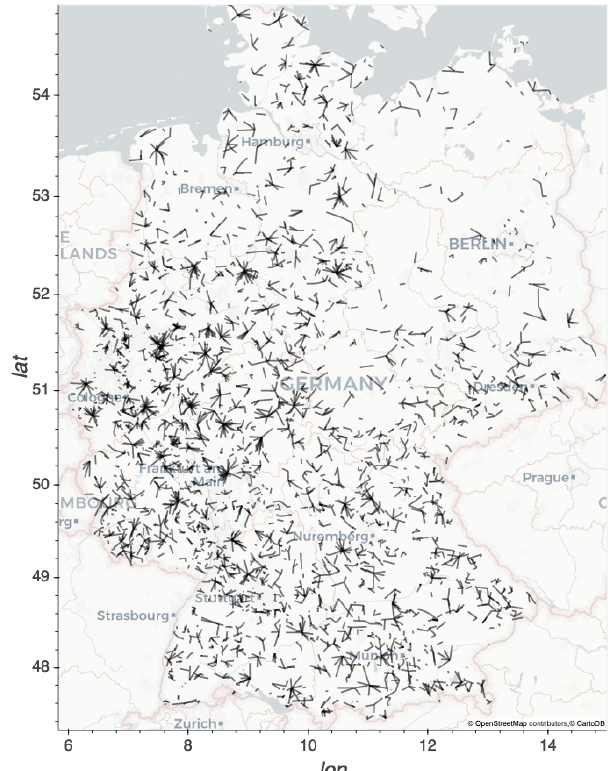
Figure 1. Map of the distribution of 3904 CMLs throughout